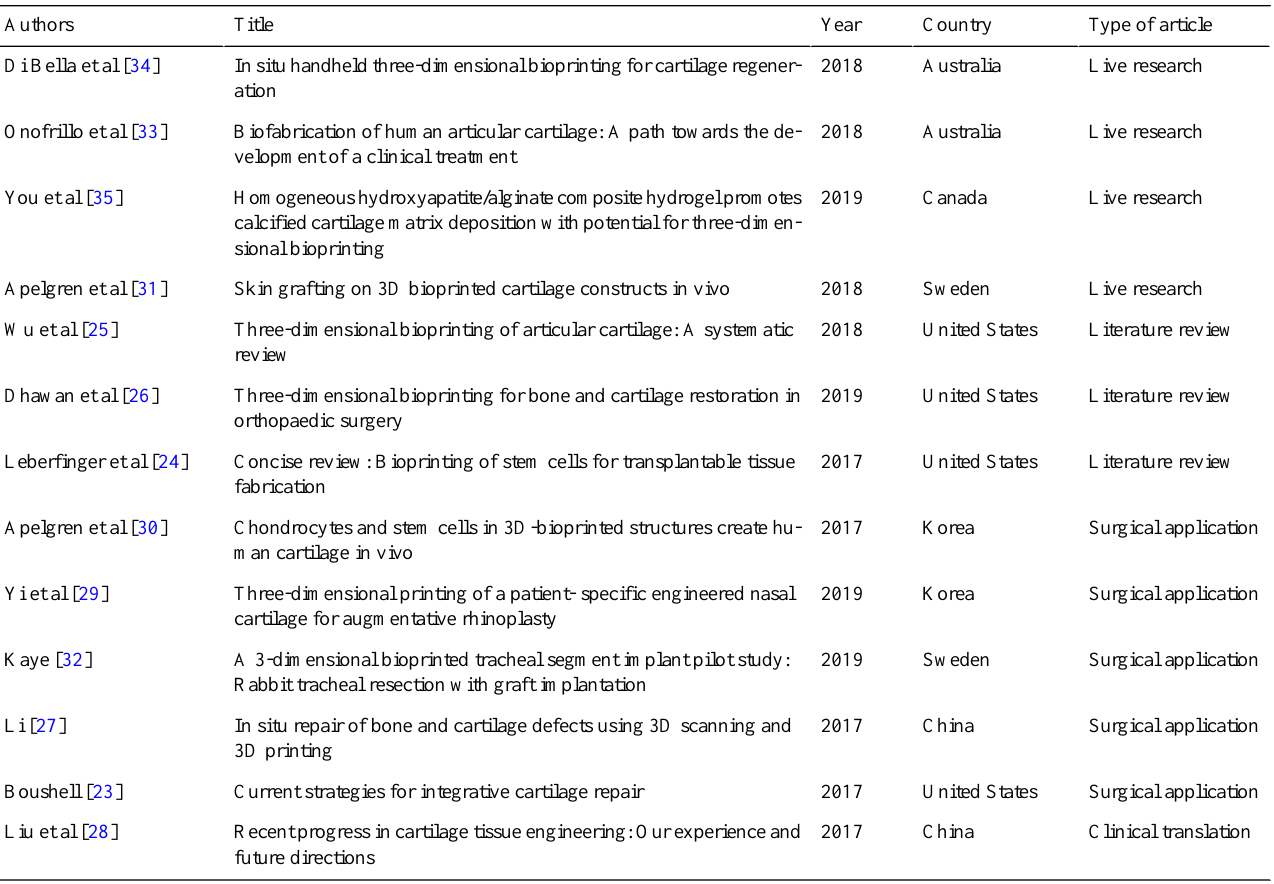
Table 2. Selected articles.